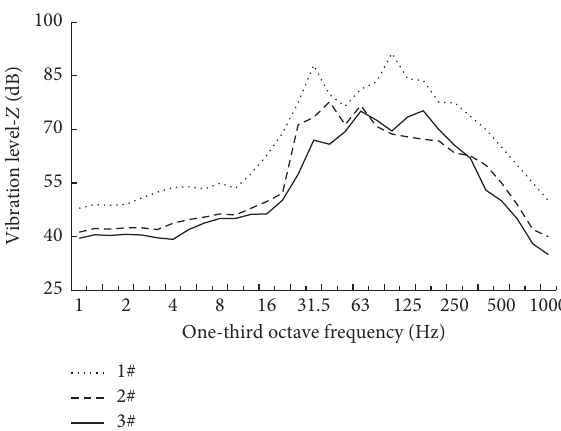
Figure 17: Vertical vibration levels of 1# ∼ 3# under one-third octave frequency.